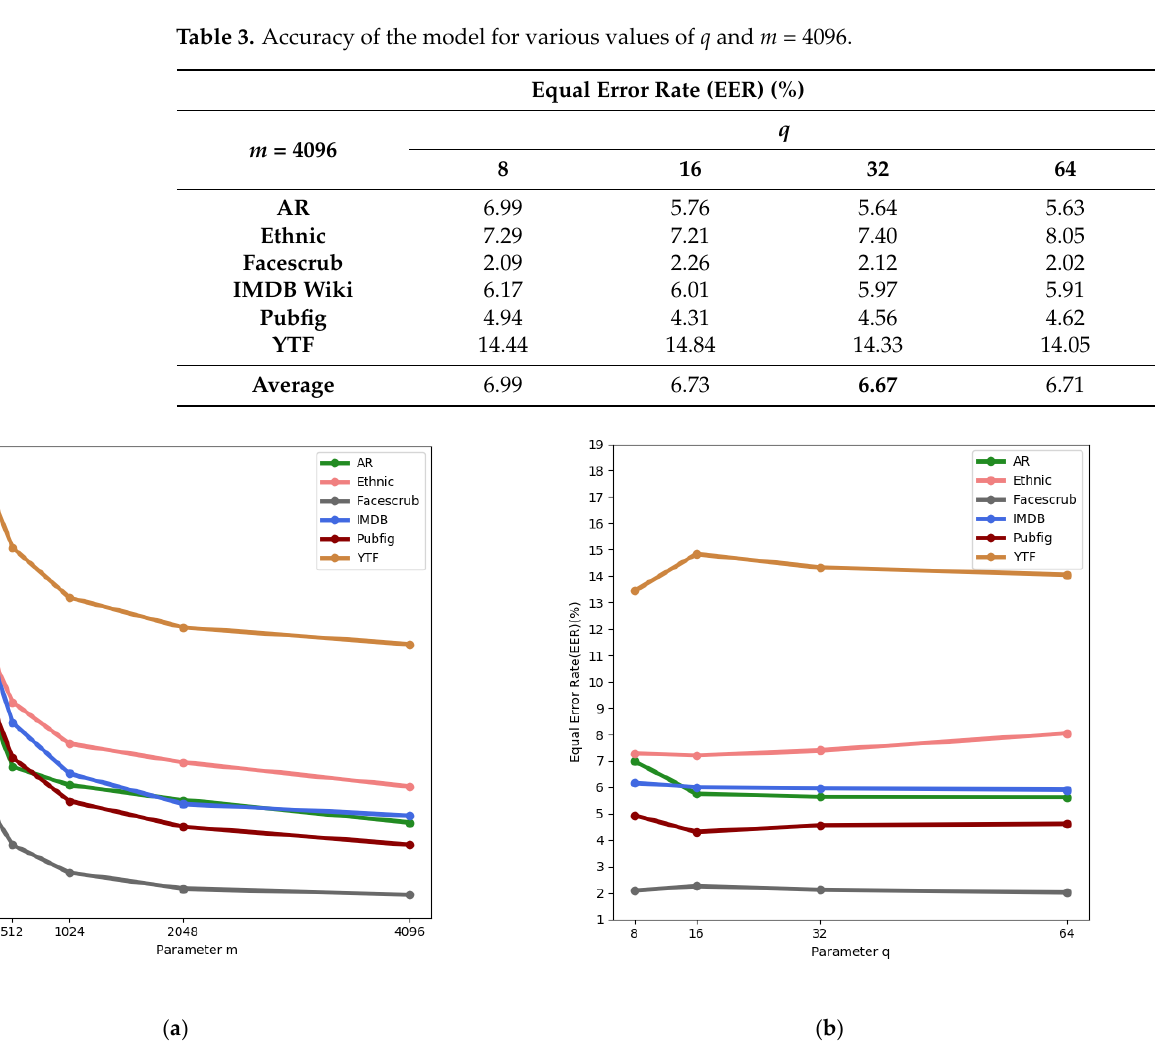
Figure 7. EER (%) for ( a ) varying m with q = 32 and ( b ) varying q with m =